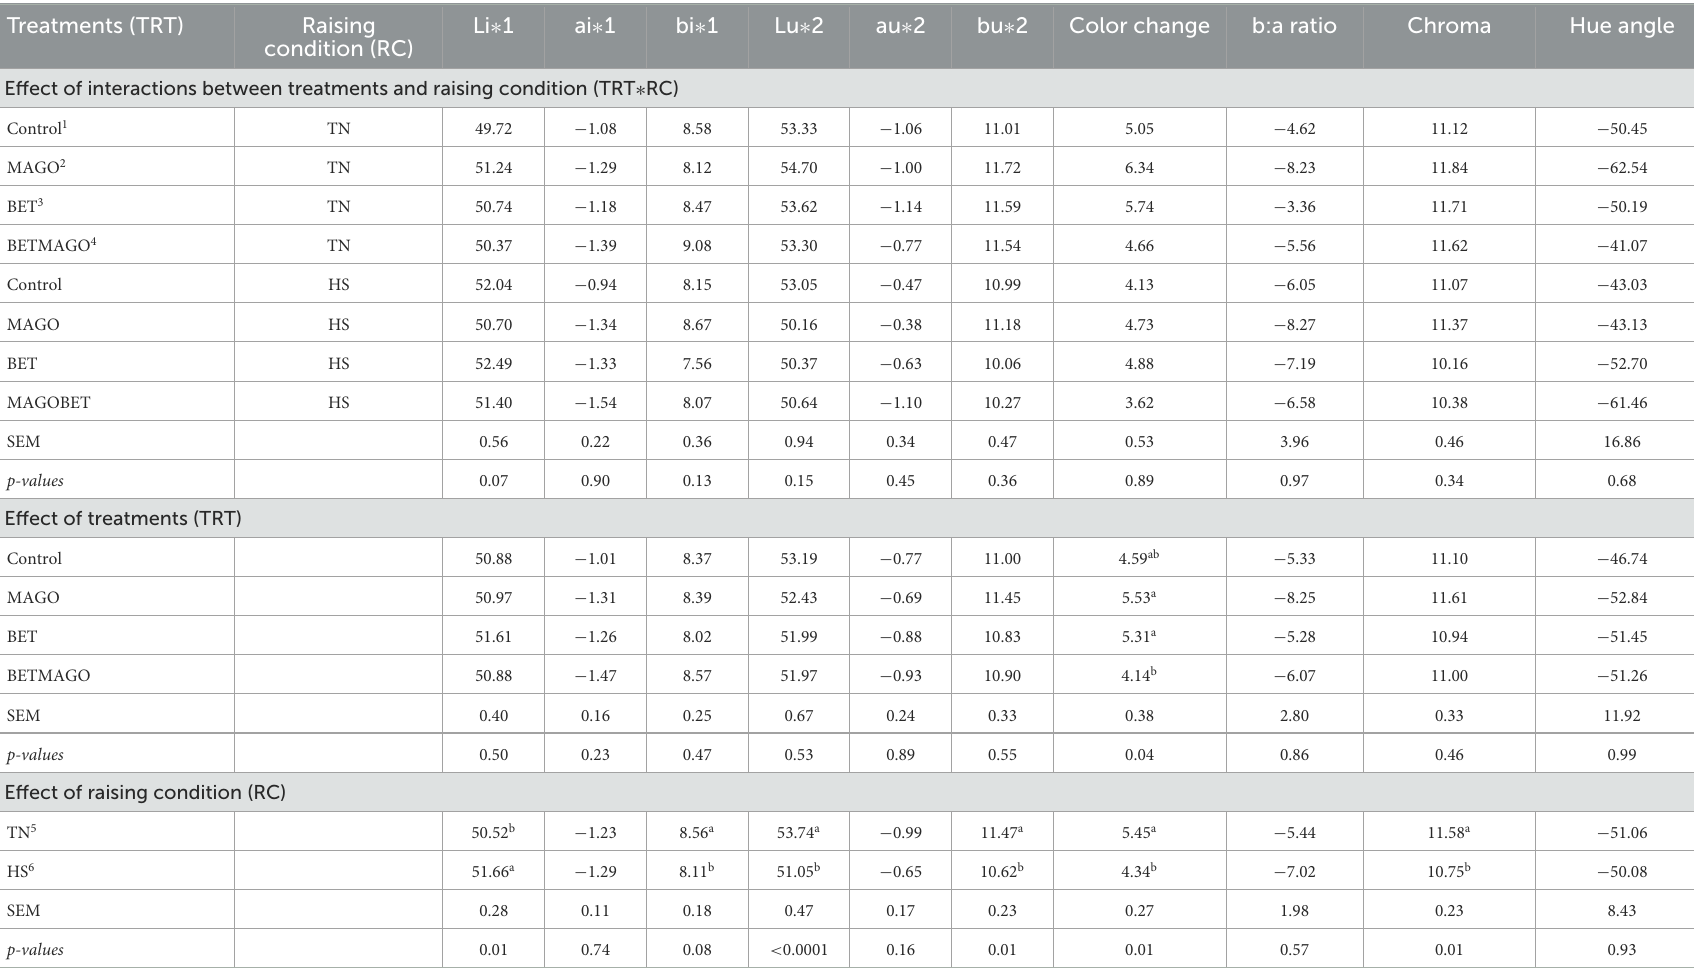
TABLE 4 Effect of the treatments on meat color derivatives of breast muscle of broiler chickens at d 35 under thermoneutral (TN) and heat stress (HS) raising conditions. Treatments (TRT) Raising condition (RC) Effect of interactions between treatments and raising condition (TRT ∗ RC)